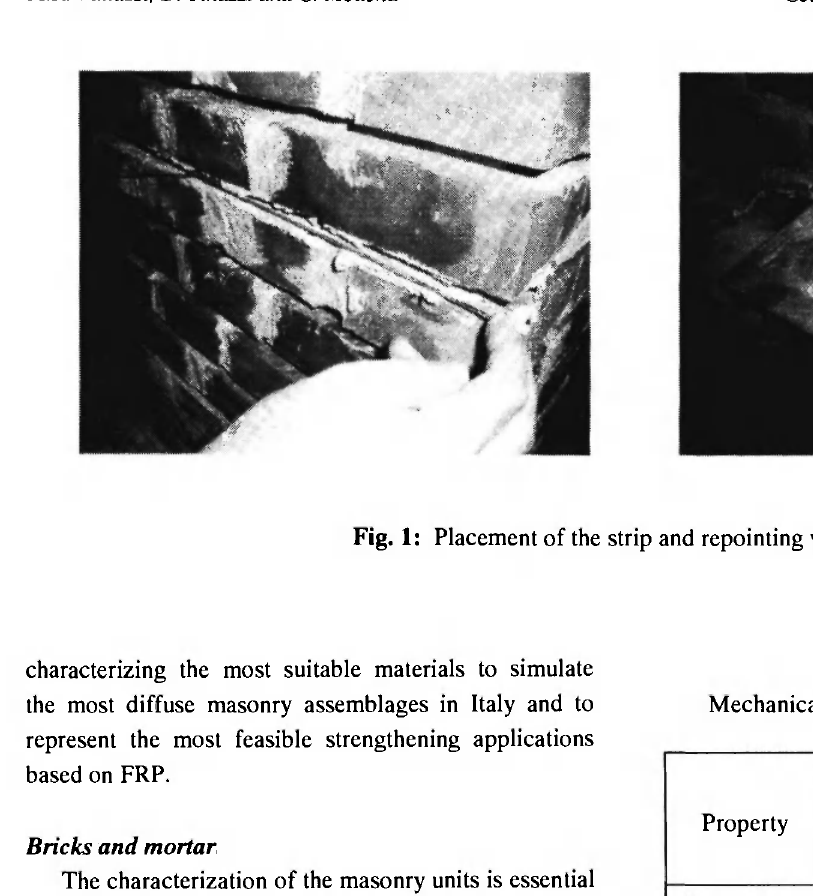
Mechanical characteristics of the masonry